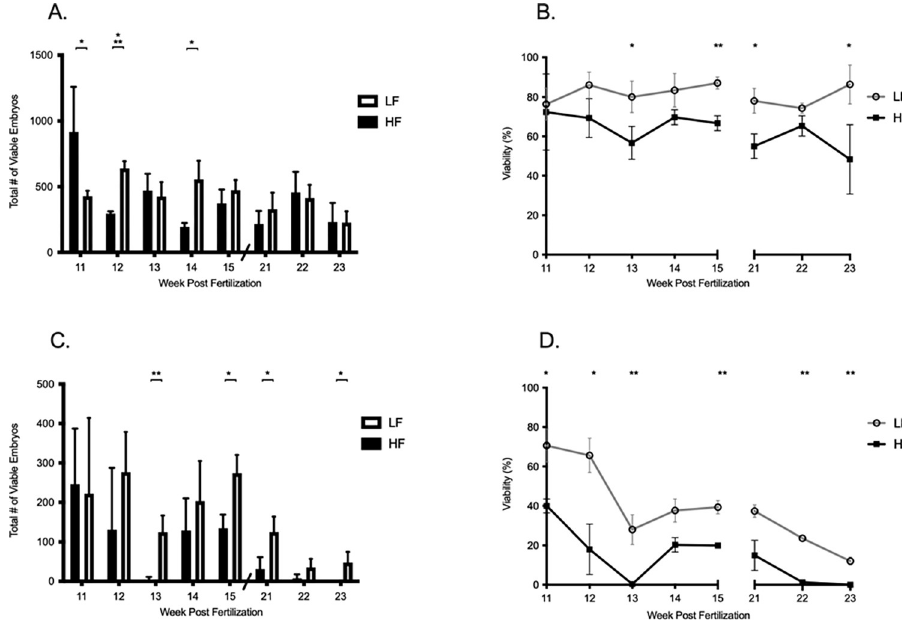
Fig 3. Measurement of reproductive performance in AB wild-type fish, F 0 generation. Reproductive performance for the F 0 (A, B) AB wild-type strain and (C, D) Tu¨ wild-type line. (A) Fecundity is defined as the total number of live embryos spawned and (B) viability is defined as the percentage of live embryos at 24-hours post fertilization. Data shown as the mean ± standard deviation. Significant differences at each week are noted with � indicating p � 0.05, �� indicating p � 0.01, and ��� indicating p � 0.001 by successive two-tailed T-Test, n = 3 represented by 30 fish from each growth treatment.